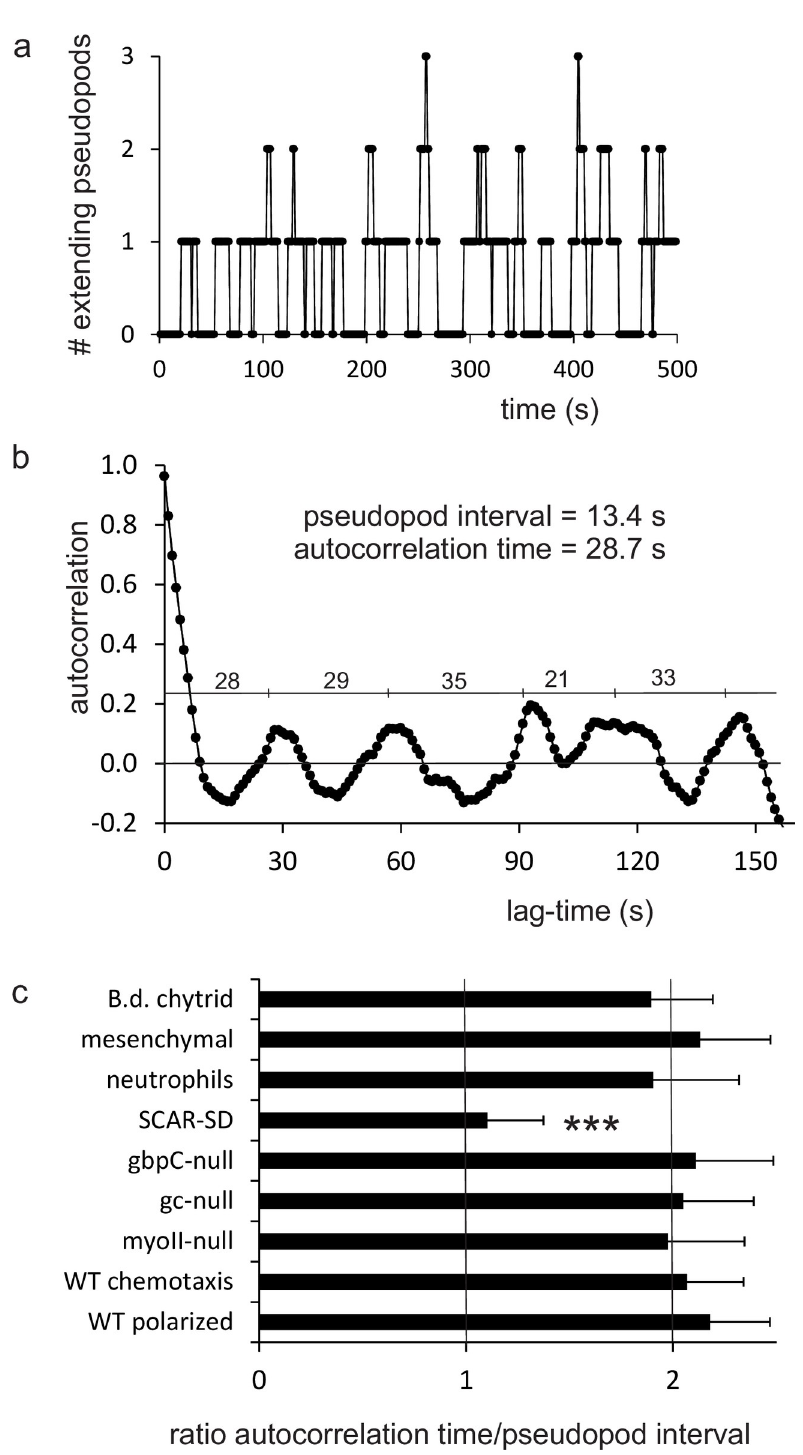
Fig 3. Autocorrelation of the number of extending pseudopods. a. Number of extending pseudopods of polarized wild-type cells during movement for 15,400 s; a small window of 500 s is shown. b. Autocorrelation of the number of extending pseudopods in polarized wild-type cells during 15,400 s; numbers indicate the time period between the maxima. The autocorrelation time is 28.7 ± 1.4 s (mean and 95% CI; n = 8). c. Ratio of autocorrelation time/pseudopod interval. The autocorrelation time of mutants and strains were determined as in panel b. The pseudopod interval was derived from [15]. The data shown are means and 95% confidence intervals. ��� , the data are significantly different